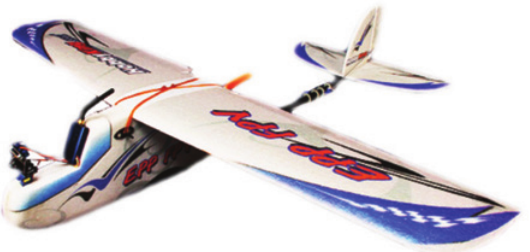
Fig. 1. Unmanned aerial vehicle used as the platform for acquisition of images